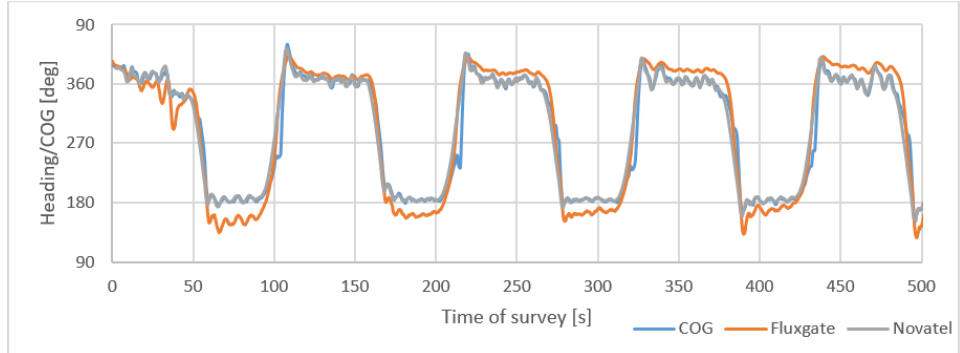
Figure 7. S atellite compass and fluxgate headings and COG during 500 s survey on linear profiles. Figure 7. Satellite compass and fluxgate headings and COG during 500 s survey on linear